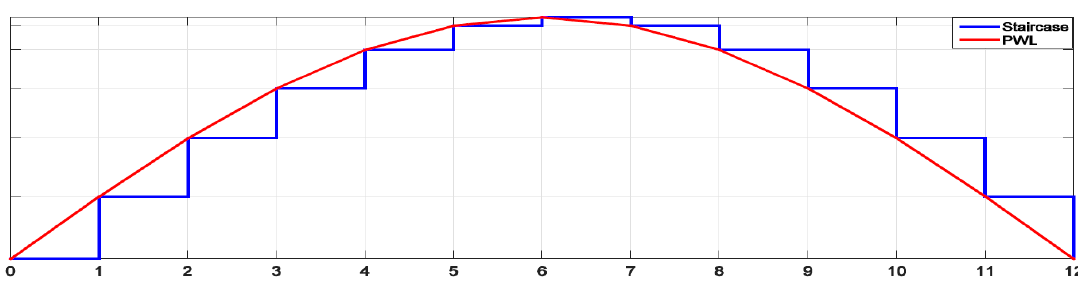
Figure 20. Example of staircase and piecewise linear (PWL) approximations for a continuous profile.